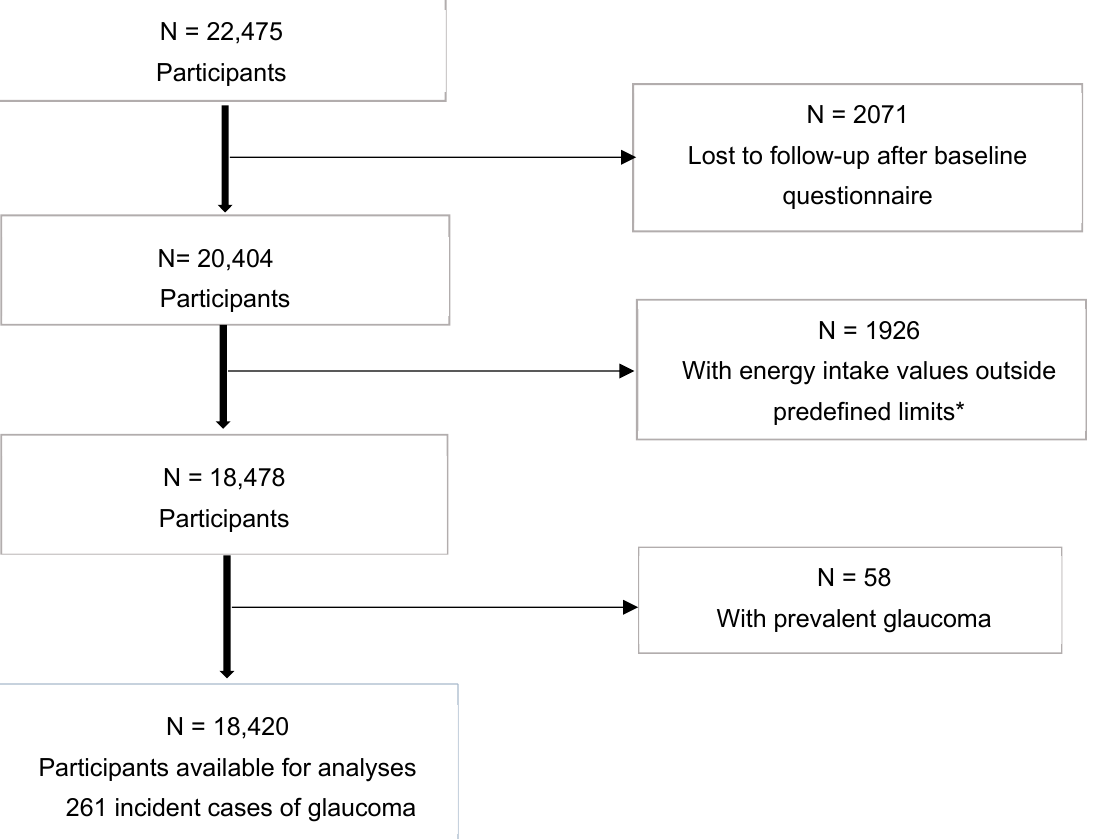
Figure 1. Flow-chart of the subjects in the Seguimiento Universidad de Navarra (SUN) Project, 12 years of follow-up. * Values out of predefined limits according to Willett